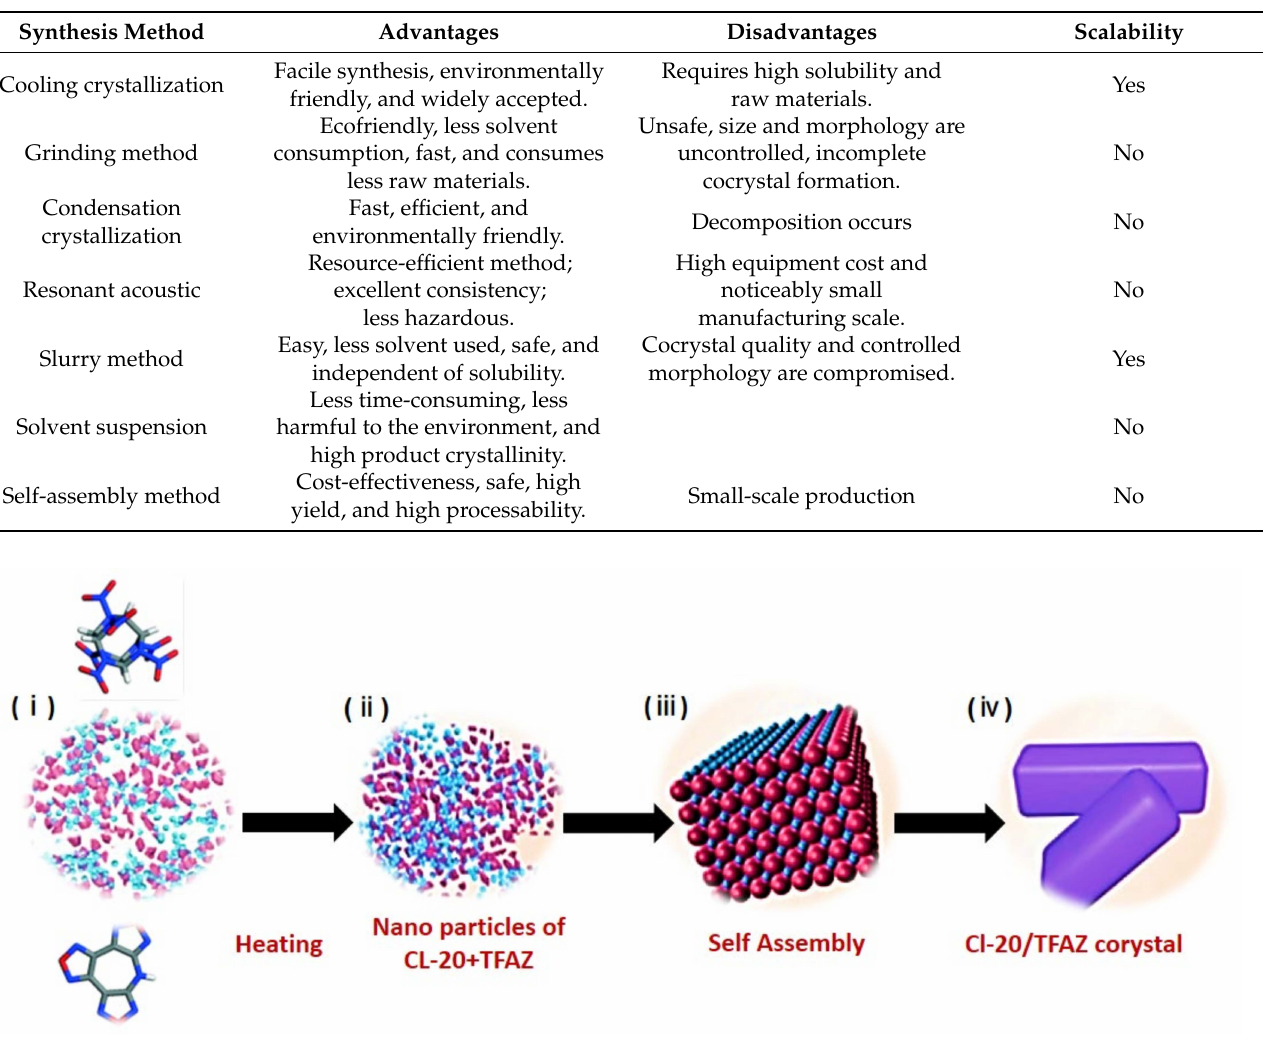
Figure 3. Self-assembly protocol for cocrystal synthesis. Reproduced from [51]. Copyright 2020, The Royal Society of